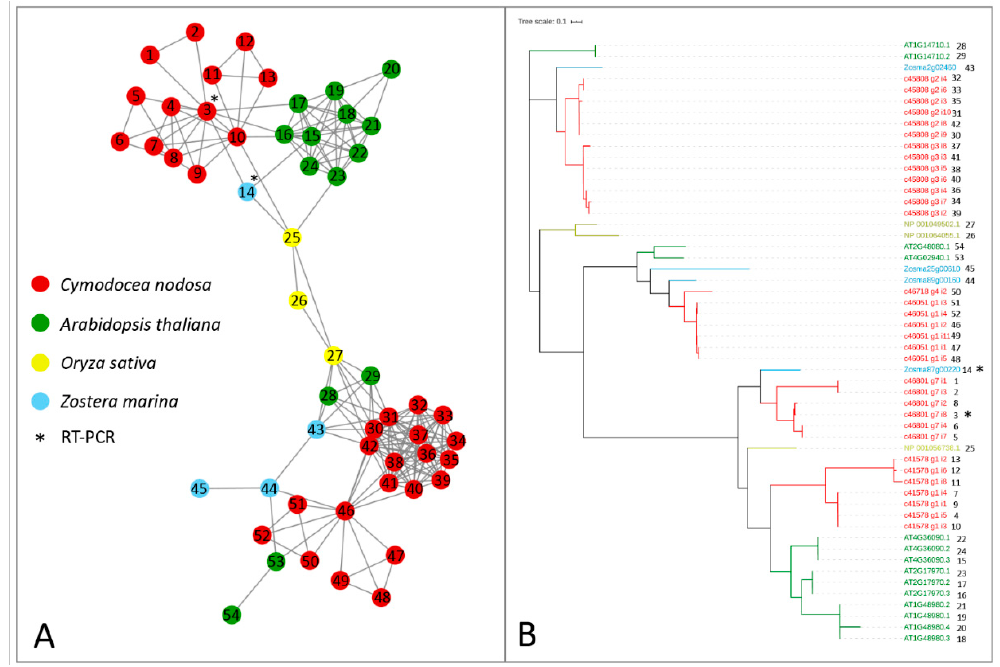
Figure 3. Orthologs/paralogs networks of erasers: ( A ) ALKBH9B and ALKBH10B (NET_160). Circles represent proteins per species, according to the legend. Grey lines represent homology relationships. Transcript sequences analysed by RT-qPCR are marked with an asterisk; ( B ) Phylogenetic tree of ALKBH9B and ALKBH10B erasers, constructed using an Approximately Maximum-Likelihood algorithm.